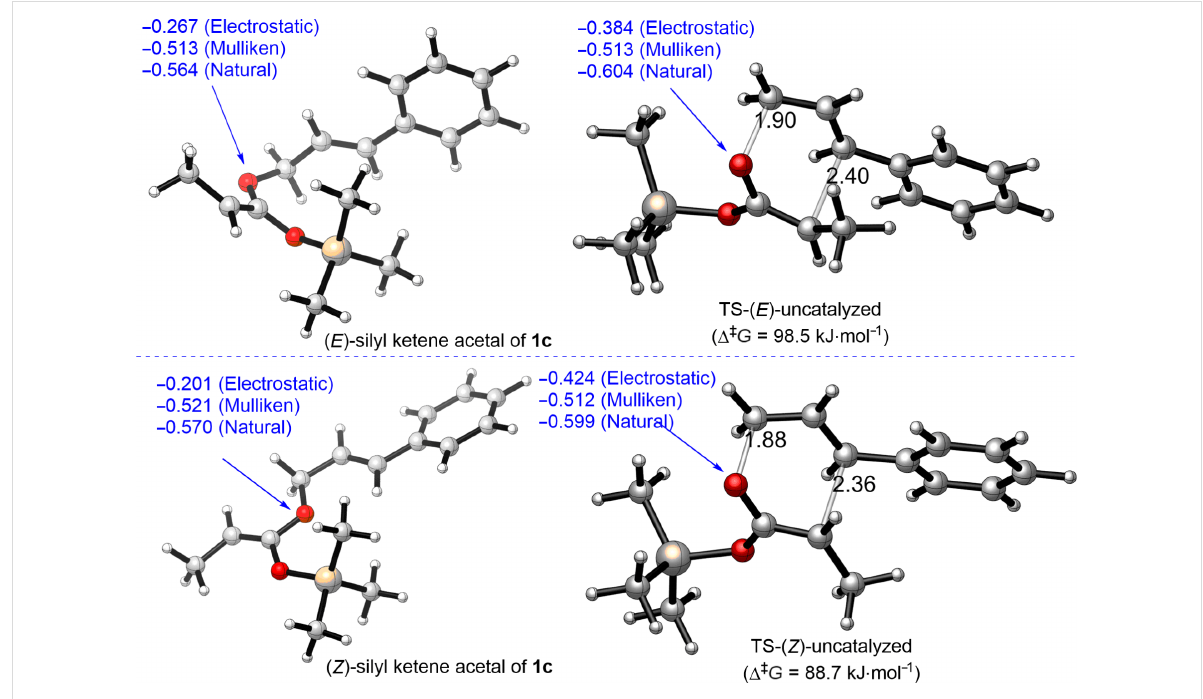
Figure 2: ω B97X-D/6-31G* calculated uncatalyzed Ireland–Claisen rearrangement of 1c . Charges on allylic oxygen (blue); C–O bond-breaking and C–C bond-forming distances in TS (black).